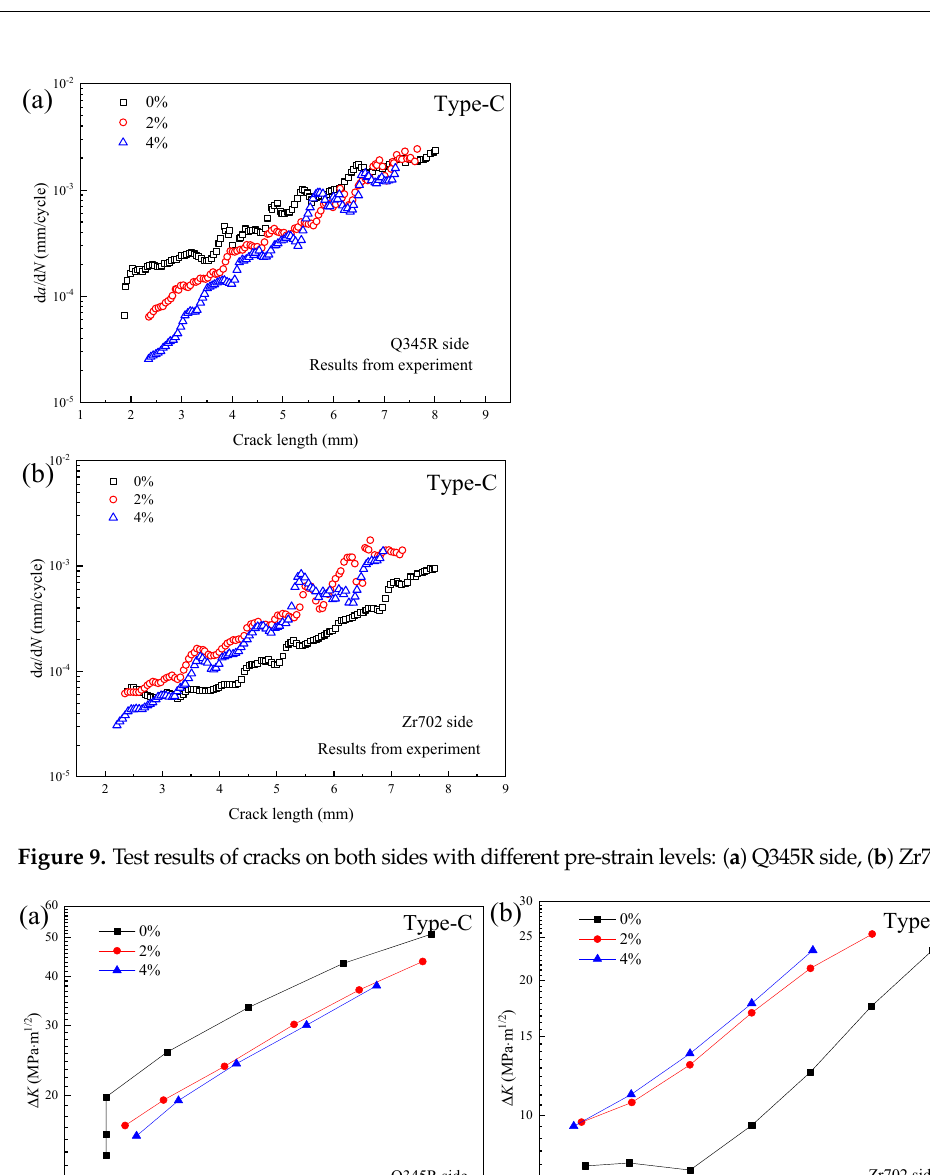
Figure 10. Effect of pre-strain on Δ K on both sides: ( a ) Q345R side, ( b ) Zr702 side. It can be seen from Figure 11 that the influence of pre-strain on the crack growth rate of the Q345R side is not significant. In the low Δ K stage, the crack growth rate decreases with the increase in the pre-strain level, while in the larger Δ K stage, the growth rate of the 0% pre-strain level is the lowest. In Figure 11b, with the gradual increase in the pre- strain level, the d a /d N- Δ K curve decreases significantly. The pre-strain treatment strengthens the Zr702 side and the resistance to fatigue crack growth increases signifi- cantly.